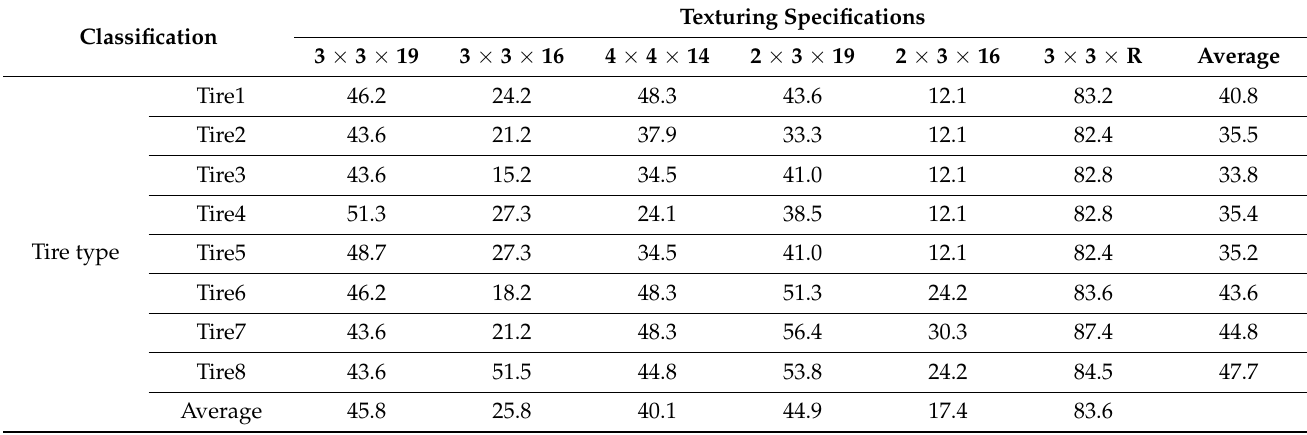
Table 6. The evaluation result of the driving simulation